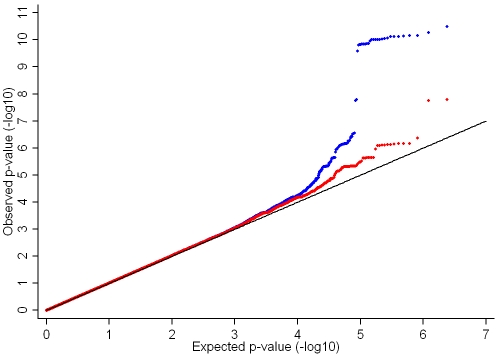
QQ plot of the ALSPAC and GOOD genome-wide meta-analysis of BMDC.Blue points show the full genome-wide results. Red points show the genome-wide results excluding the RANKL region (chr 13: 42000–42150Kb).